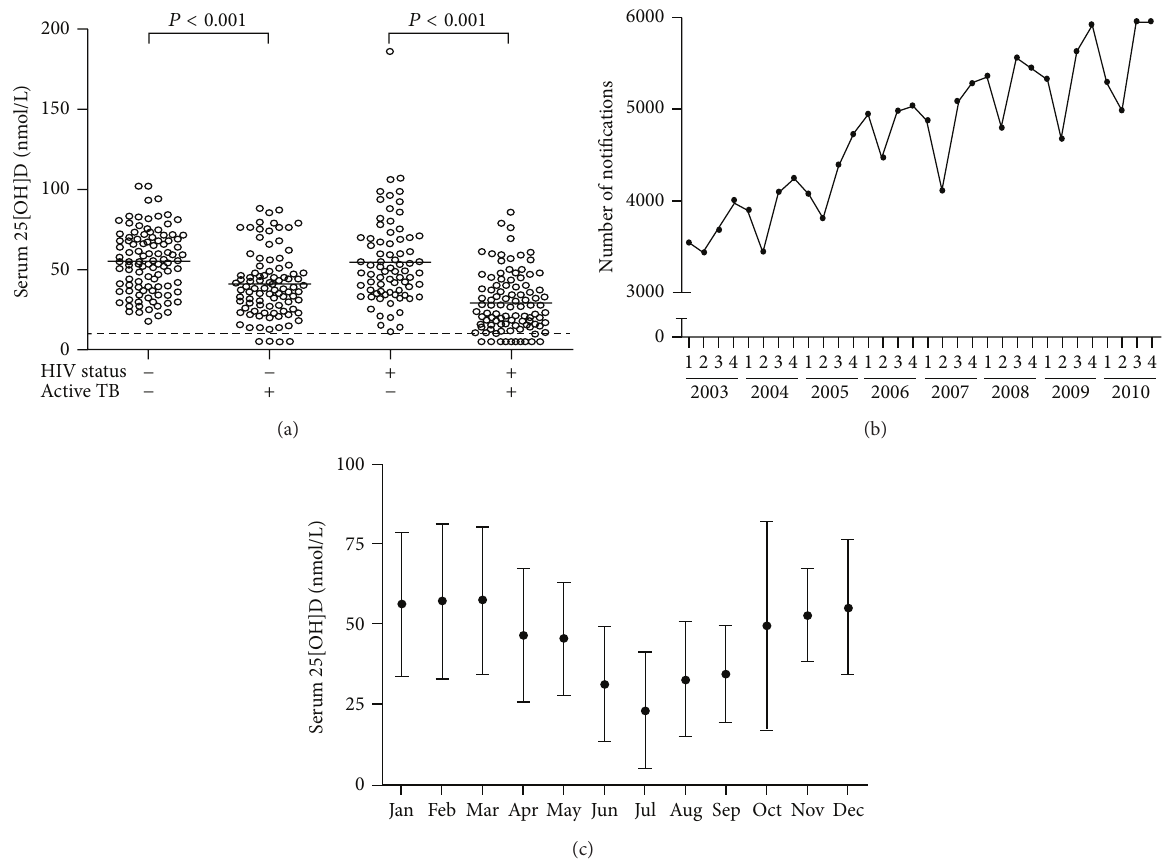
Figure 3: Active TB associates with vitamin D deficiency and seasonal fluctuations in Cape Town, South Africa. (a) Serum 25[OH]D concentration by HIV and TB status. Bars represent means. Dashed line represents limit of detection (10nmol/L). (b) New TB notifications by quarter, 2003 to 2010. (c) Monthly variation in mean serum 25[OH]D concentration (all participants, 𝑛 = 370 ). Error bars indicate SD. The figure is adapted from Martineau et al.